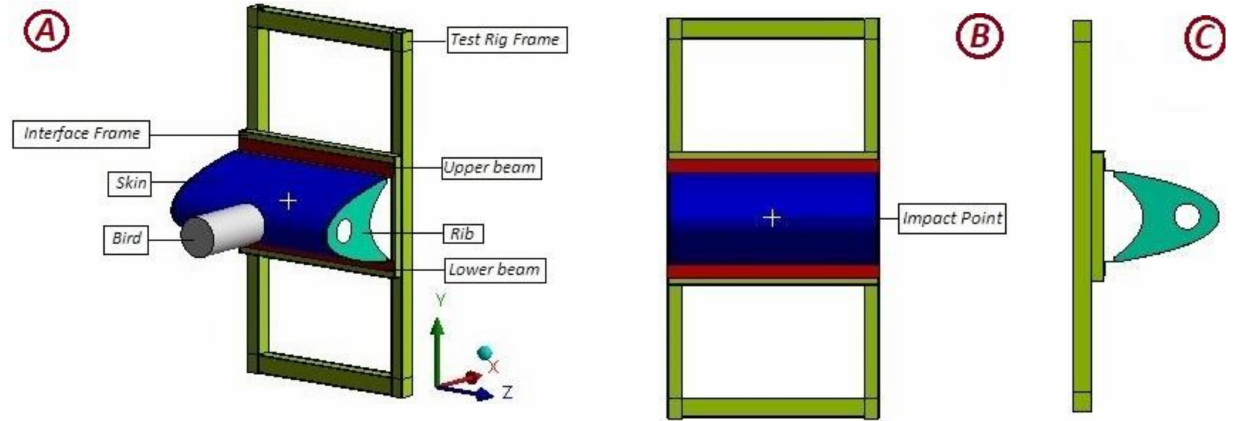
Figure 2. Present Numerical Setup. ( A ) 3D view with sub-components; ( B ) Frontal view; ( C ) Side view.